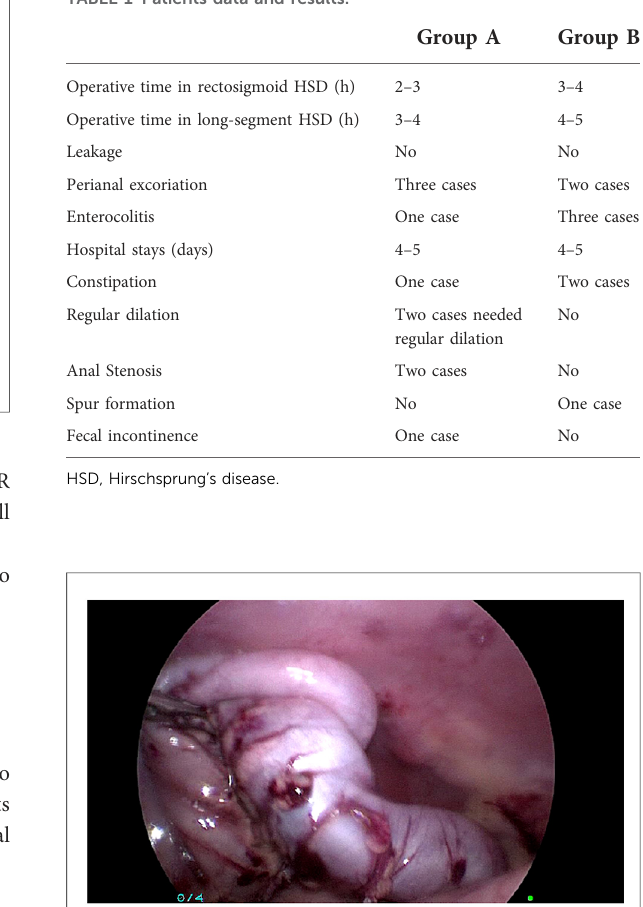
TABLE 1 Patients data and results.